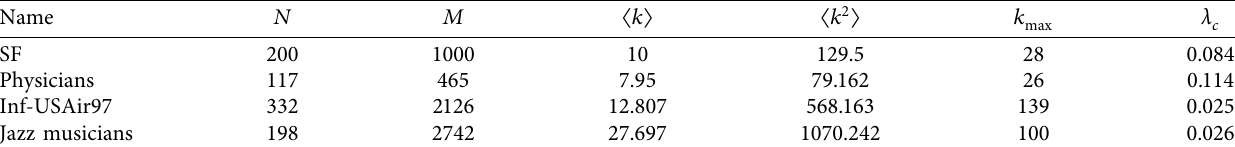
Table 1: Network statistics.